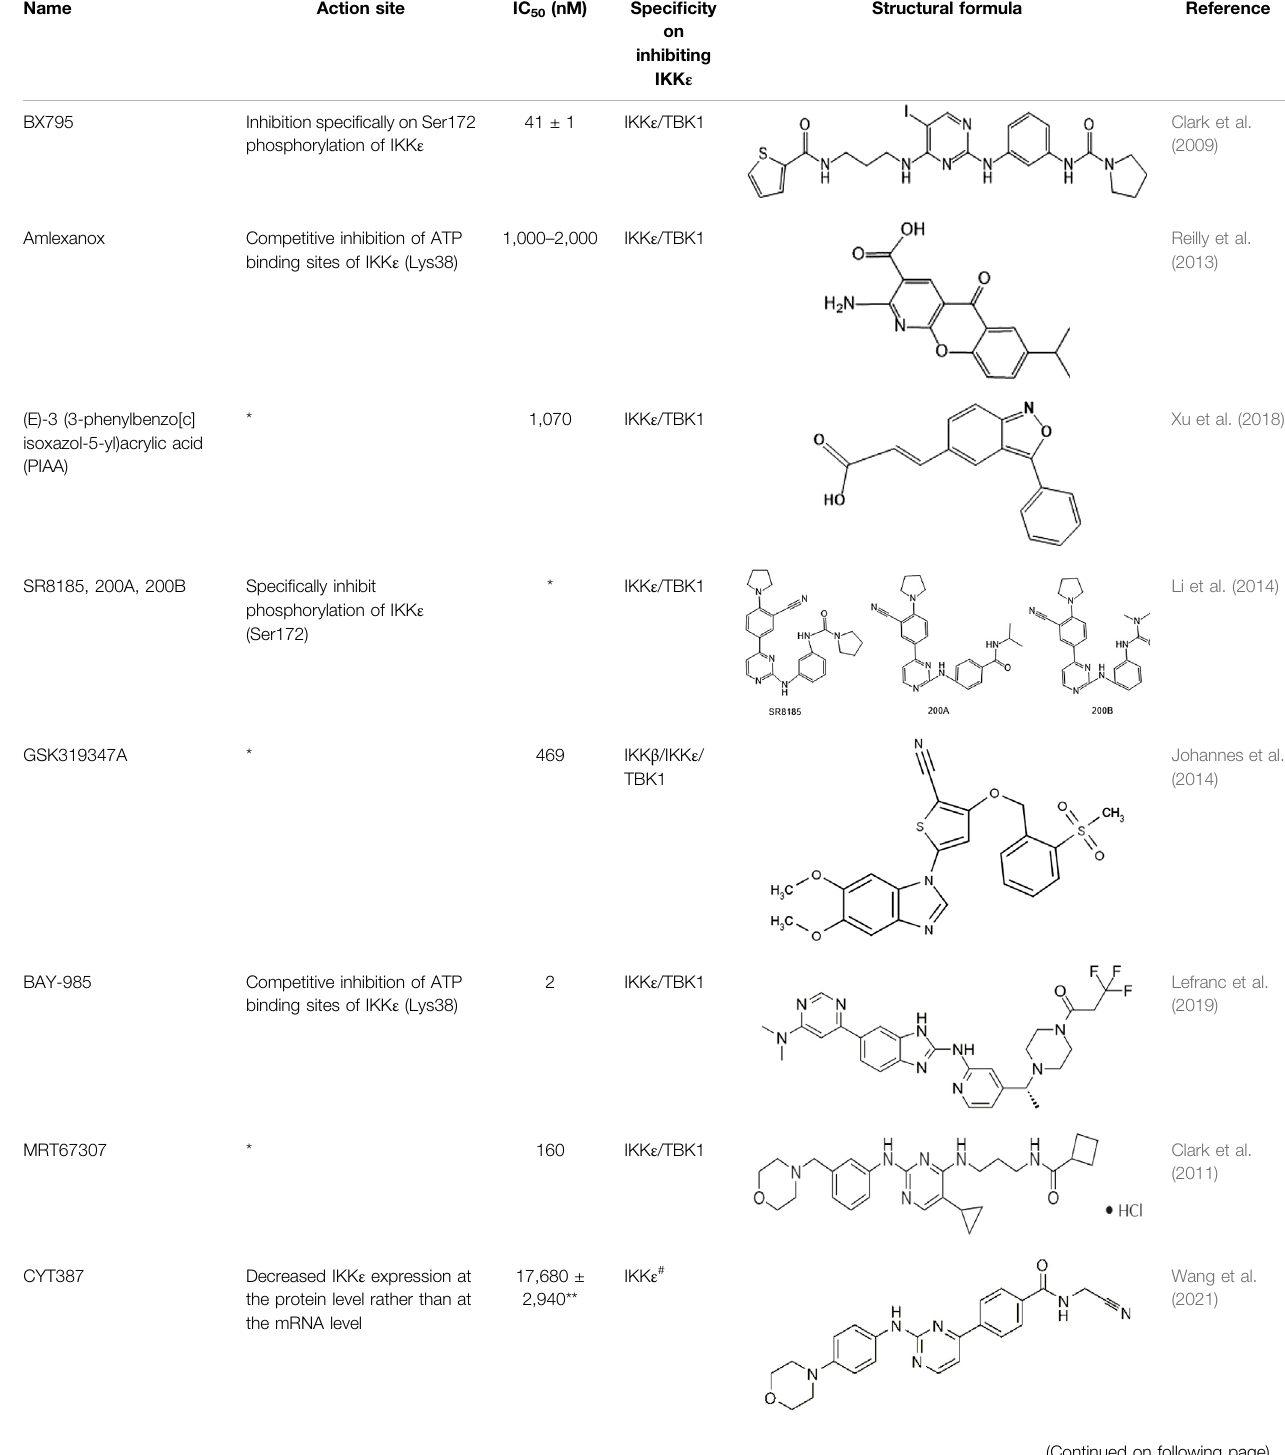
TABLE 1 | Properties and action sites of IKK ε